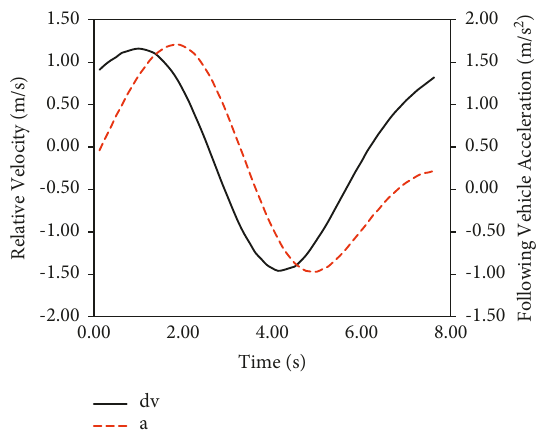
Figure 3: Example of acceleration and relative speed curves of following vehicle in the following